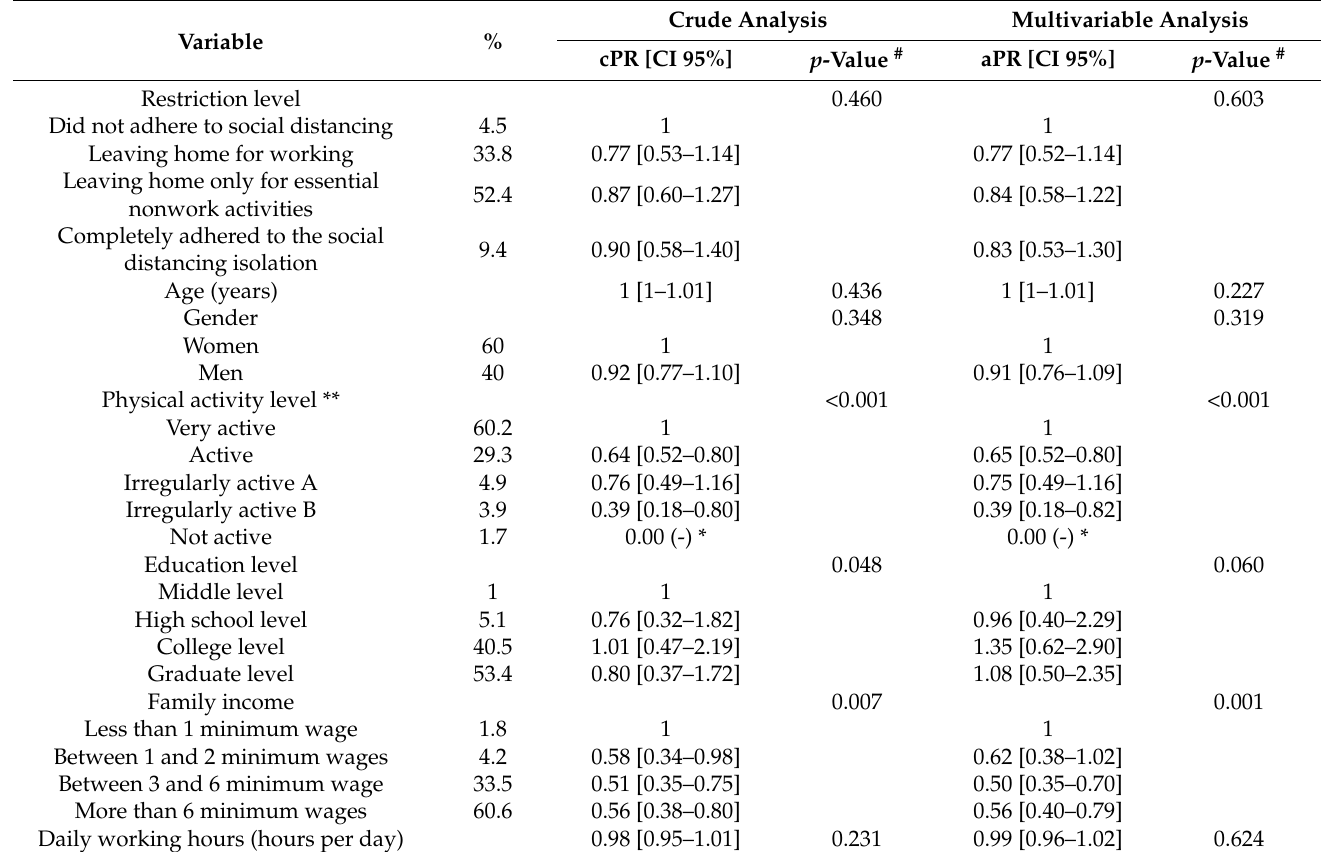
Table 3. Crude and multivariable analysis with estimates of the crude prevalence ratios (cPR) and adjusted prevalence ratios (aPR) for the factors associated with decreased physical activity level. Crude Analysis Multivariable Analysis Variable % cPR [CI 95%] p -Value # aPR [CI 95%] p -Value # 0.460